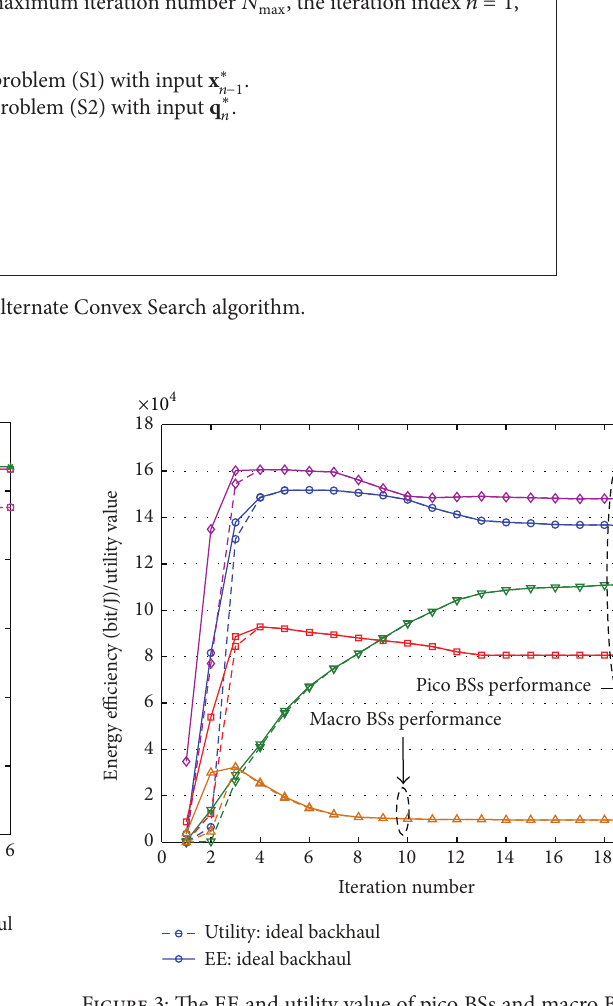
Figure 3: The EE and utility value of pico BSs and macro BSs with respect to iteration number under ideal backhaul